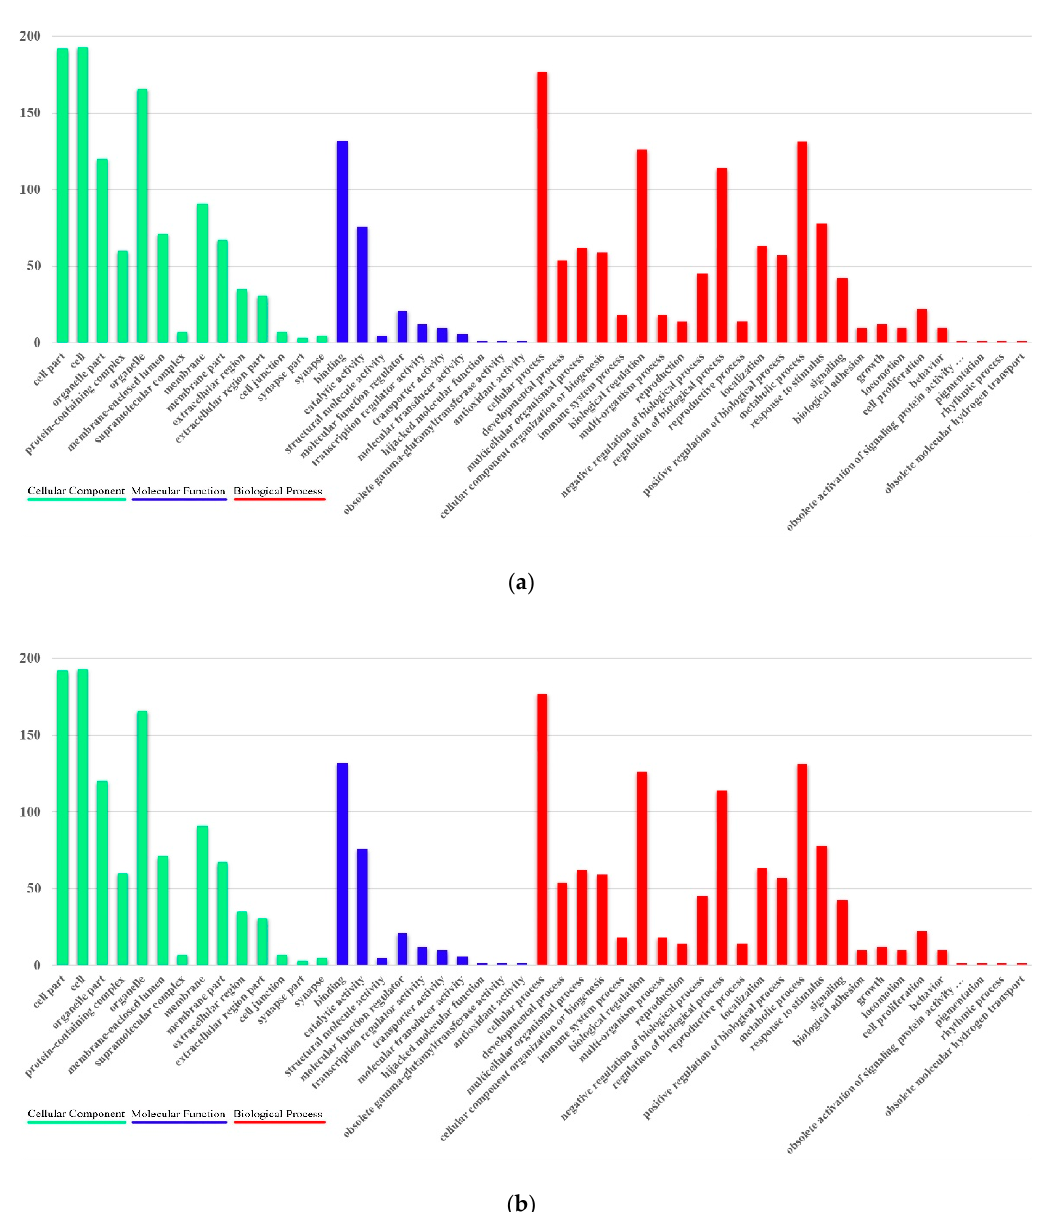
Figure 7. Functional distribution of positively selected genes (PSGs). ( a ) Functional distribution of PSGs according to the gene ontology (GO) database. The y-axis reveals the GO functional categories, while the number of genes in each category is plotted on the x-axis. ( b ) Functional distribution of PSGs according to the Kyoto Encyclopedia of Genes and Genomes (KEGG)pathway database. The y-axis illustrates the KEGG functional categories, while the number of genes in each category is plotted on the x-axis.